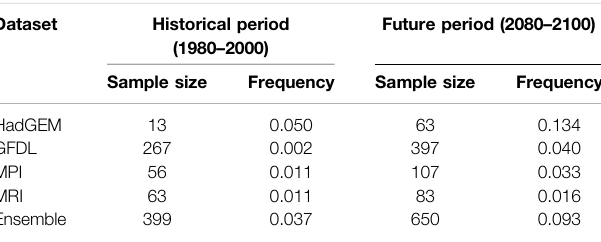
TABLE 1 | Sample size and annual frequency of category three to fi ve hurricanes for each